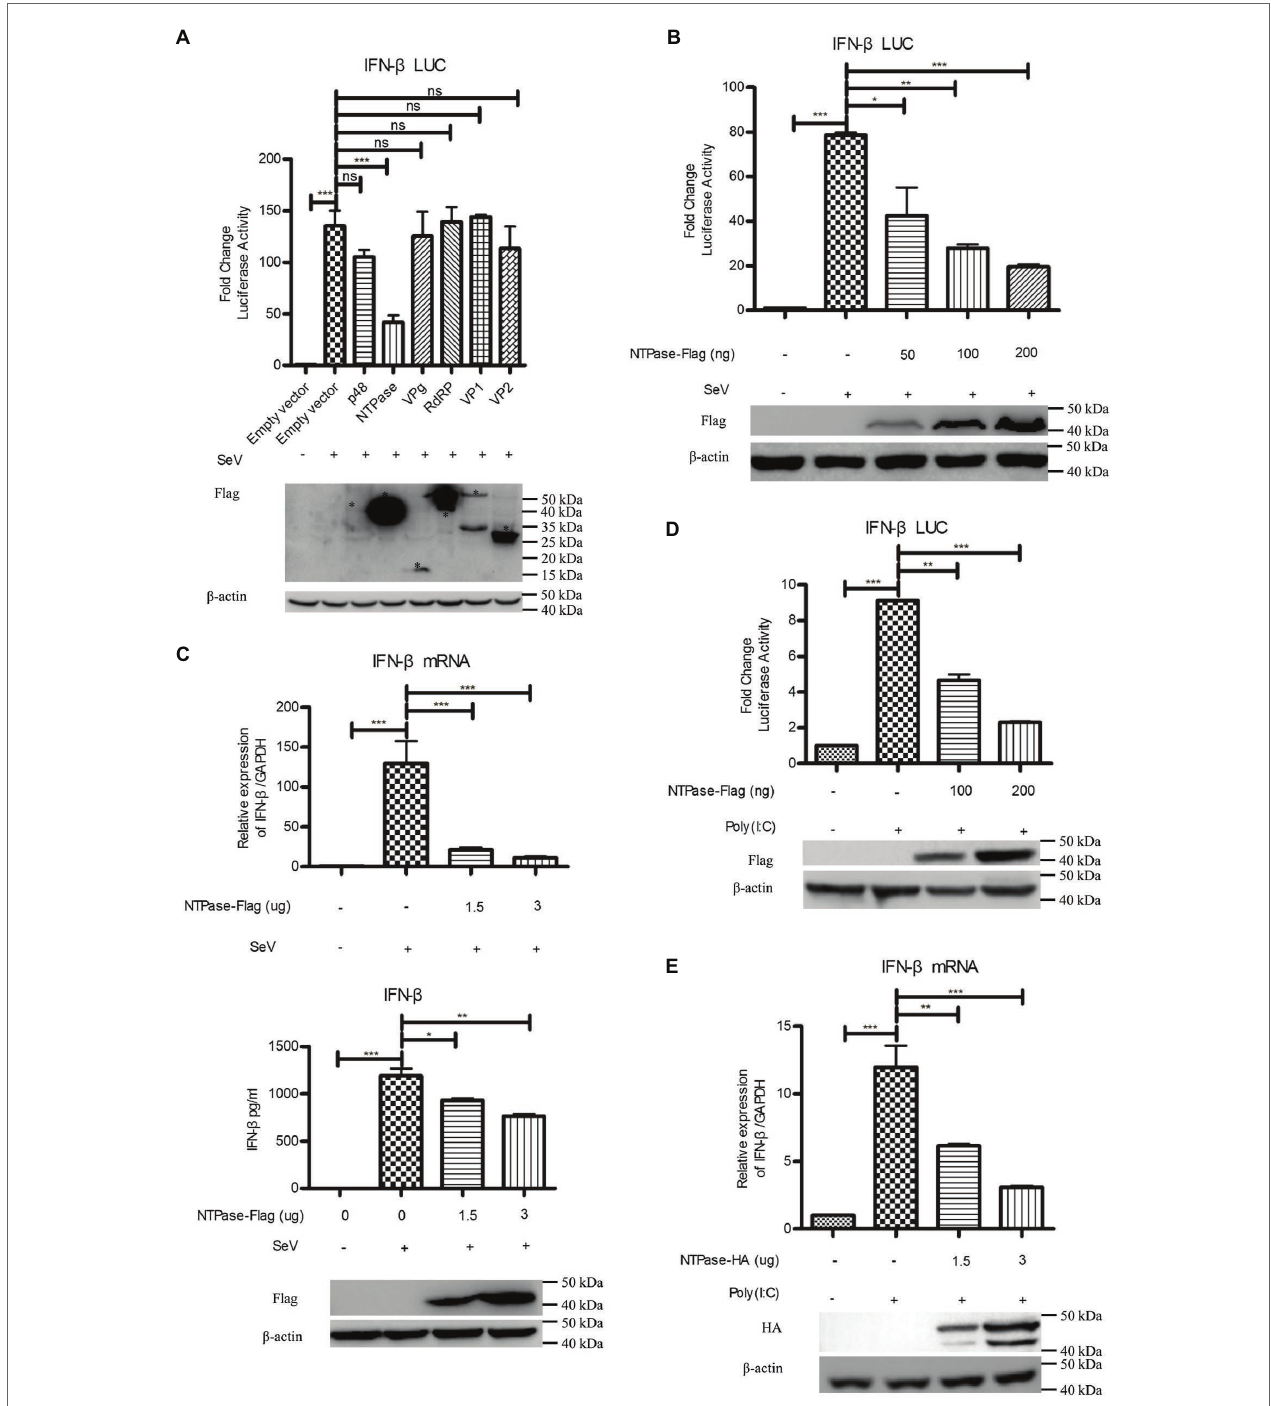
FIGURE 2 | HuNoV NTPase inhibits IFN- β production induced by SeV and Poly(I:C) in a dose-dependent manner. (A) Identification of HuNoV proteins that inhibit IFN- β expression. 200 ng plasmid expressing Flag-tagged p48, NTPase, VPg, RdRP, VP1, VP2, or empty vector together with 100 ng p125-Luc and 20 ng phRL-TK was cotransfected into HEK 293T cells preseeded in 48-well plates for 24 h. Cells were stimulated with or without SeV for 16 h. Reporter activities were determined with dual luciferase report (DLR) assay. The expression of HuNoV proteins was analyzed by WB using an anti-Flag Ab. An asterisk indicates HuNoV protein. (B) HuNoV NTPase inhibits SeV-induced activation of IFN- β promoter. Various amounts of Flag-tagged NTPase expression plasmid or empty vector together with 100 ng p125-Luc and 20 ng phRL-TK were cotransfected into HEK 293T cells preseeded in 48-well plates for 24 h. Cells were stimulated with or without SeV for 16 h. Reporter activities were determined with DLR assay. (C) HuNoV NTPase inhibits the SeV-induced production of IFN- β . HEK 293T cells in 6-well plates